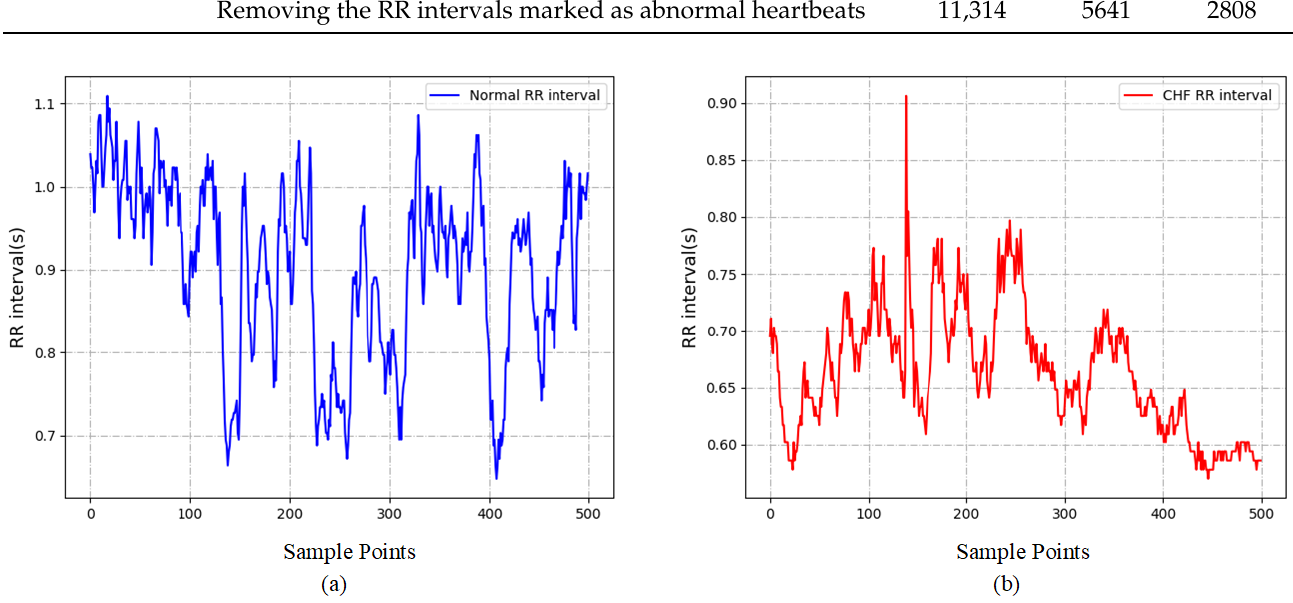
Figure 2. Two demonstrative examples for the RR intervals corresponding to ( a ) normal subjects and ( b ) CHF